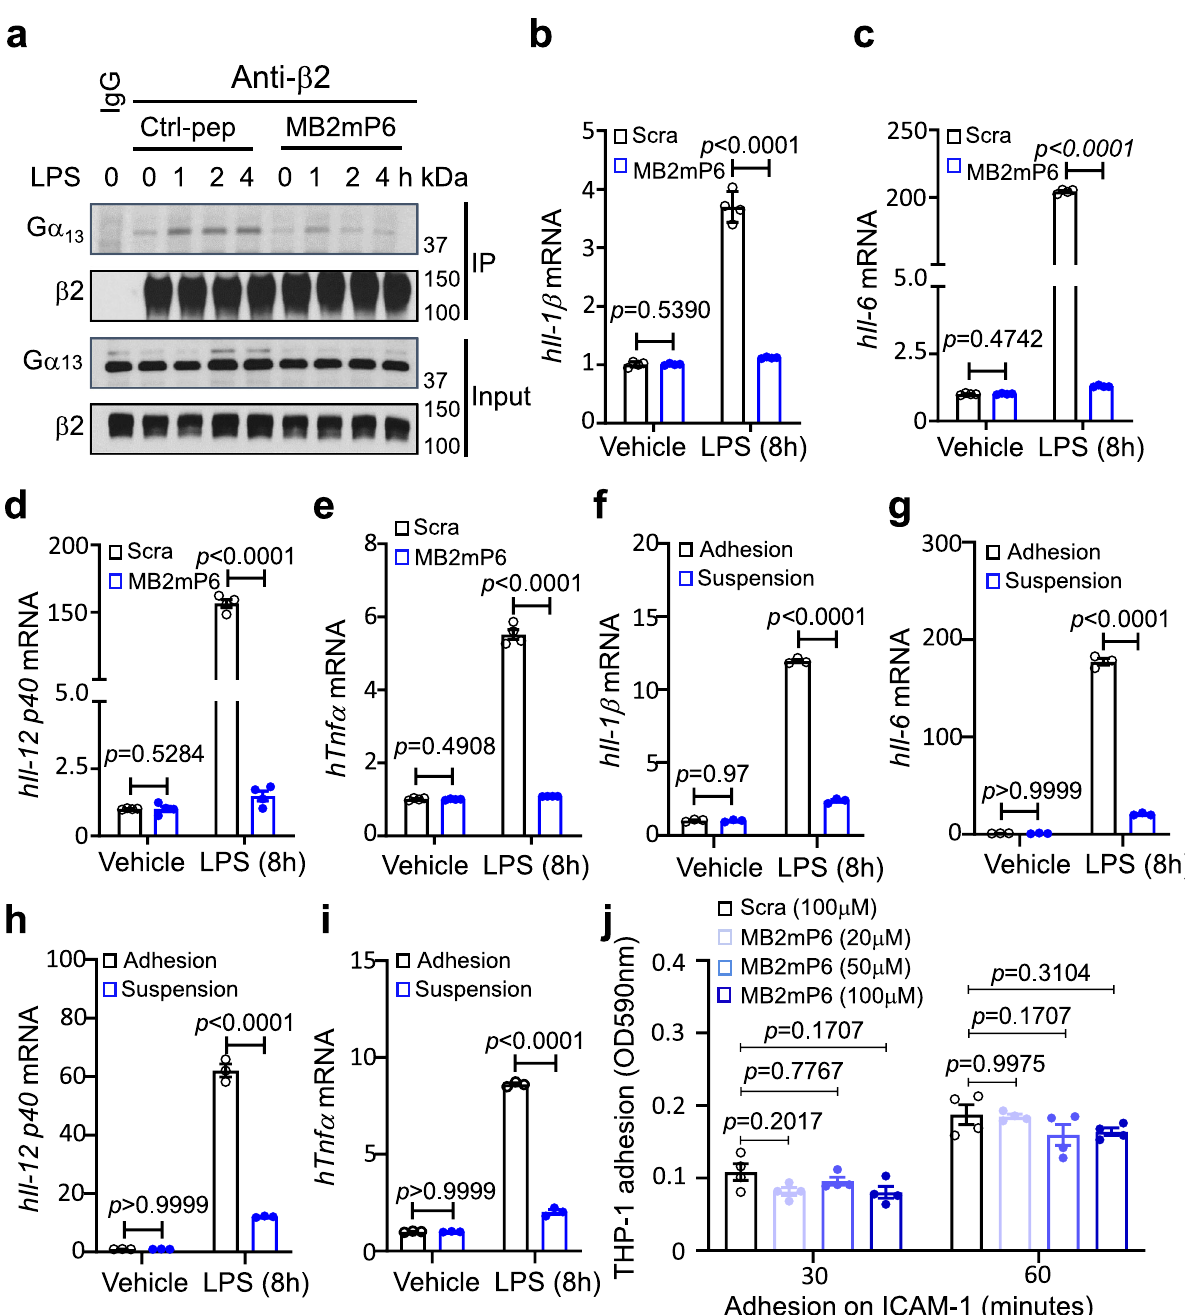
Fig. 1 MB2mP6 blocks G α 13 interactions with β 2 integrins and inhibit adhesion-dependent macrophage cytokine expression. a Representative immunoblots (from three independent experiments) of anti- β 2 antibody-co-immunoprecipitated integrin β 2 subunit and G α 13 in macrophages differentiated from PMA-stimulated THP-1 cells. The macrophages were pretreated with MB2mP6 or control peptide HLPN (50 μ M) for 20 min and then stimulated with LPS (100 ng mL − 1 ) for the indicated time prior to immunoprecipitation. Immunoprecipitates and total cell lysates were then immunoblotted with both anti- β α – e Comparison between MB2mP6 HLPN and scrambled peptide control (Scra) in Il-1 β ( b ), Il-6 ( c ), Il-12 p40 ( d ), and 2 -integrin and anti-G 13 antibodies. b Tnf α ( e ) mRNA expression in THP-1-derived macrophages stimulated with 100 ng mL − 1 LPS. The mRNA expression was detected by qRT-PCR (all groups, n = 4, independent cultures). f – i Comparison between adherent and non-adherent THP-1-derived macrophages in the levels of cytokine IL-1 β ( f ), IL-6 ( g ), IL-12 p40 ( h ), and TNF α ( i ) expression as detected by qRT-PCR (all groups, n = 3, independent cultures). j No effect of MB2mP6 pretreatment (20 − 100 μ M) on adhesion of THP-1-derived macrophages onto hICAM-1 (10 μ g mL − 1 ) precoated in 48-well plates (all groups, n = 4, independent cultures). All data are shown as mean ± SEM. Data in ( b – j ) were analyzed by two-way ANOVA with the post hoc Bonferroni ’ s multiple comparisons test ( b – e ) or Sidak ’ s multiple comparisons ( f – i ) or Tukey ’ s multiple comparisons tests ( j